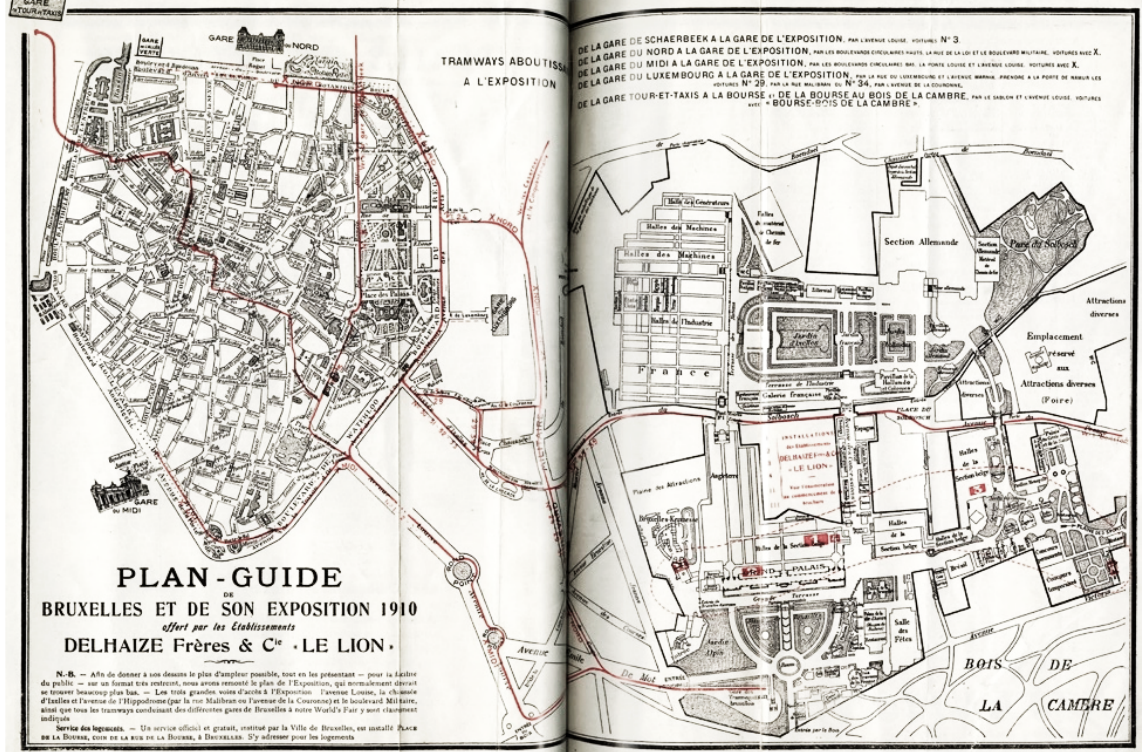
Figure 6. The World’s Fair and the redevelopment of the tramways (Jaumain, 2010, pp.